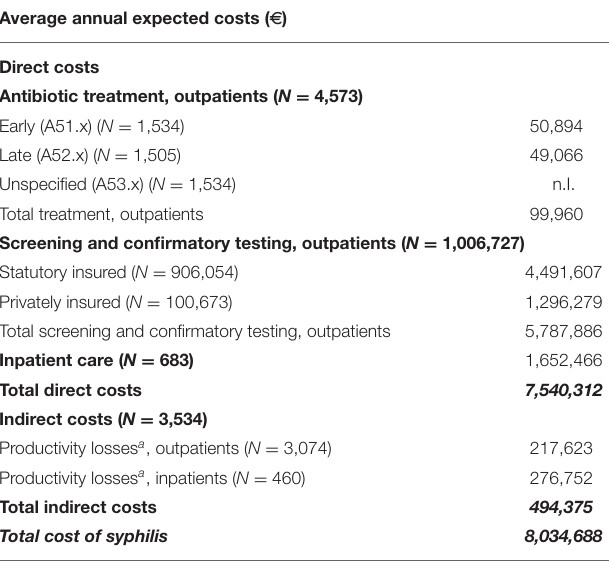
TABLE 4 | Expected economic burden of syphilis in Germany. Missing data was coded n.I. (no information). Average annual expected costs ( e